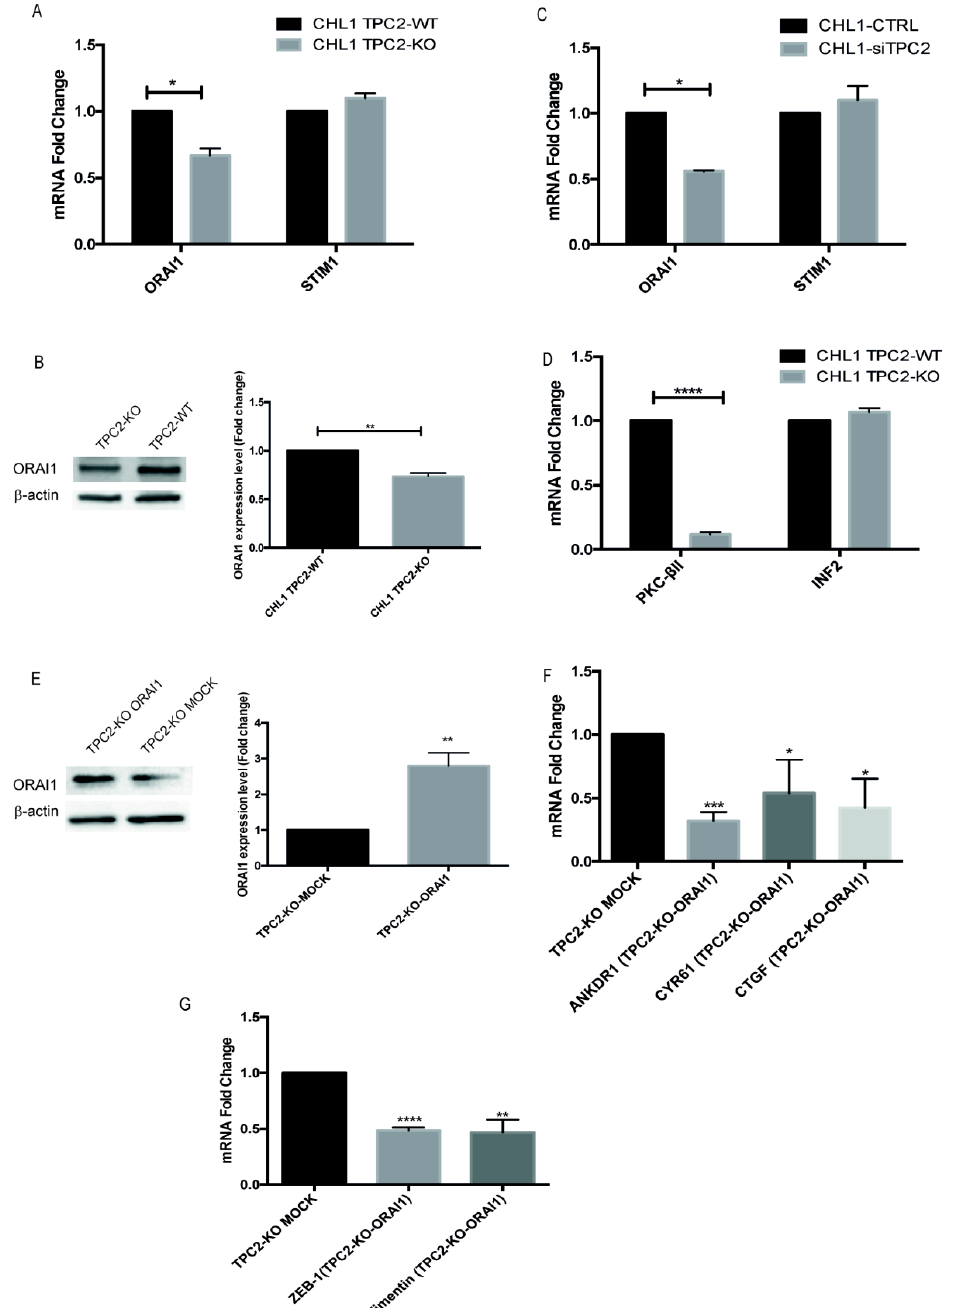
Figure 5. Possible mechanism involved in YAP / TAZ regulation mediated by TPC2. ( A ) qPCR analysis of ORAI1 and STIM1 in CHL1 WT and TPC2 KO cells. ( B ) ORAI1 protein expression in CHL1 WT and TPC2 KO cells normalised to β -actin. Relative density of ORAI1 / β -actin. ( C ) qPCR analysis of ORAI1 and STIM1 expression after the transient silencing of TPC2. ( D ) qPCR analysis of PKC- β II and INF2 expression in CHL1 WT and TPC2 KO cells. ( E ) ORAI1 protein expression after 24 h from transfection in CHL1 TPC2 KO-MOCK and ORAI1 expressing cells, normalised to β -actin. Relative density of ORAI1 / β -actin. ( F ) qPCR analysis of YAP / TAZ target gene expression after ORAI1 overexpression in CHL1 TPC2 KO cells. H3 was used as an internal control. ( G ) qPCR analysis of vimentin and ZEB1 expression after ORAI1 overexpression in CHL1 TPC2 KO cells. H3 was used as an internal control. Data in bar charts represent the mean ± s.e.m. of three independent experiments (* p < 0.05; ** p < 0.01; *** p < 0.001; **** p <